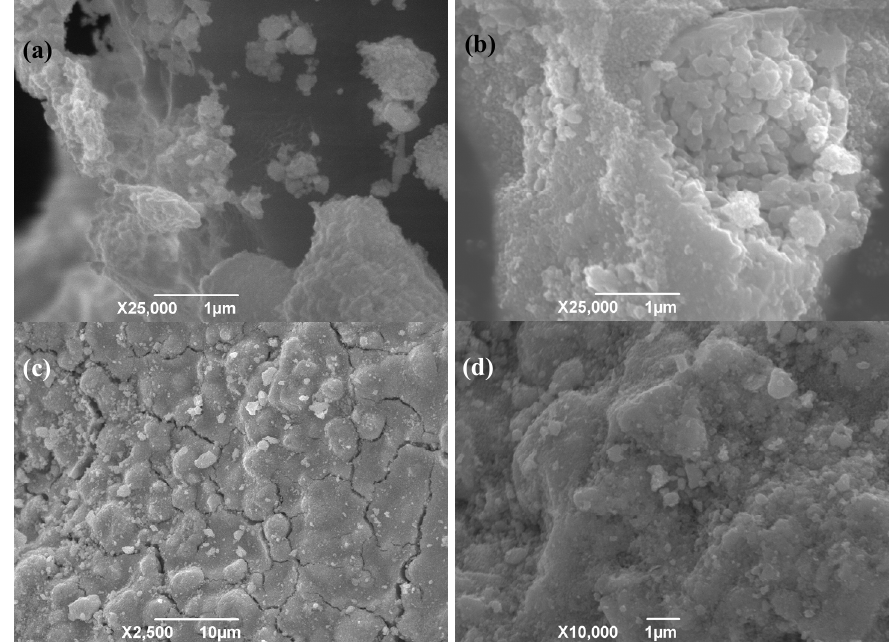
Figure 4. SEM images of products collected from the inlet zone ( a and b ), and hot-zone ( c and d ) of experiment